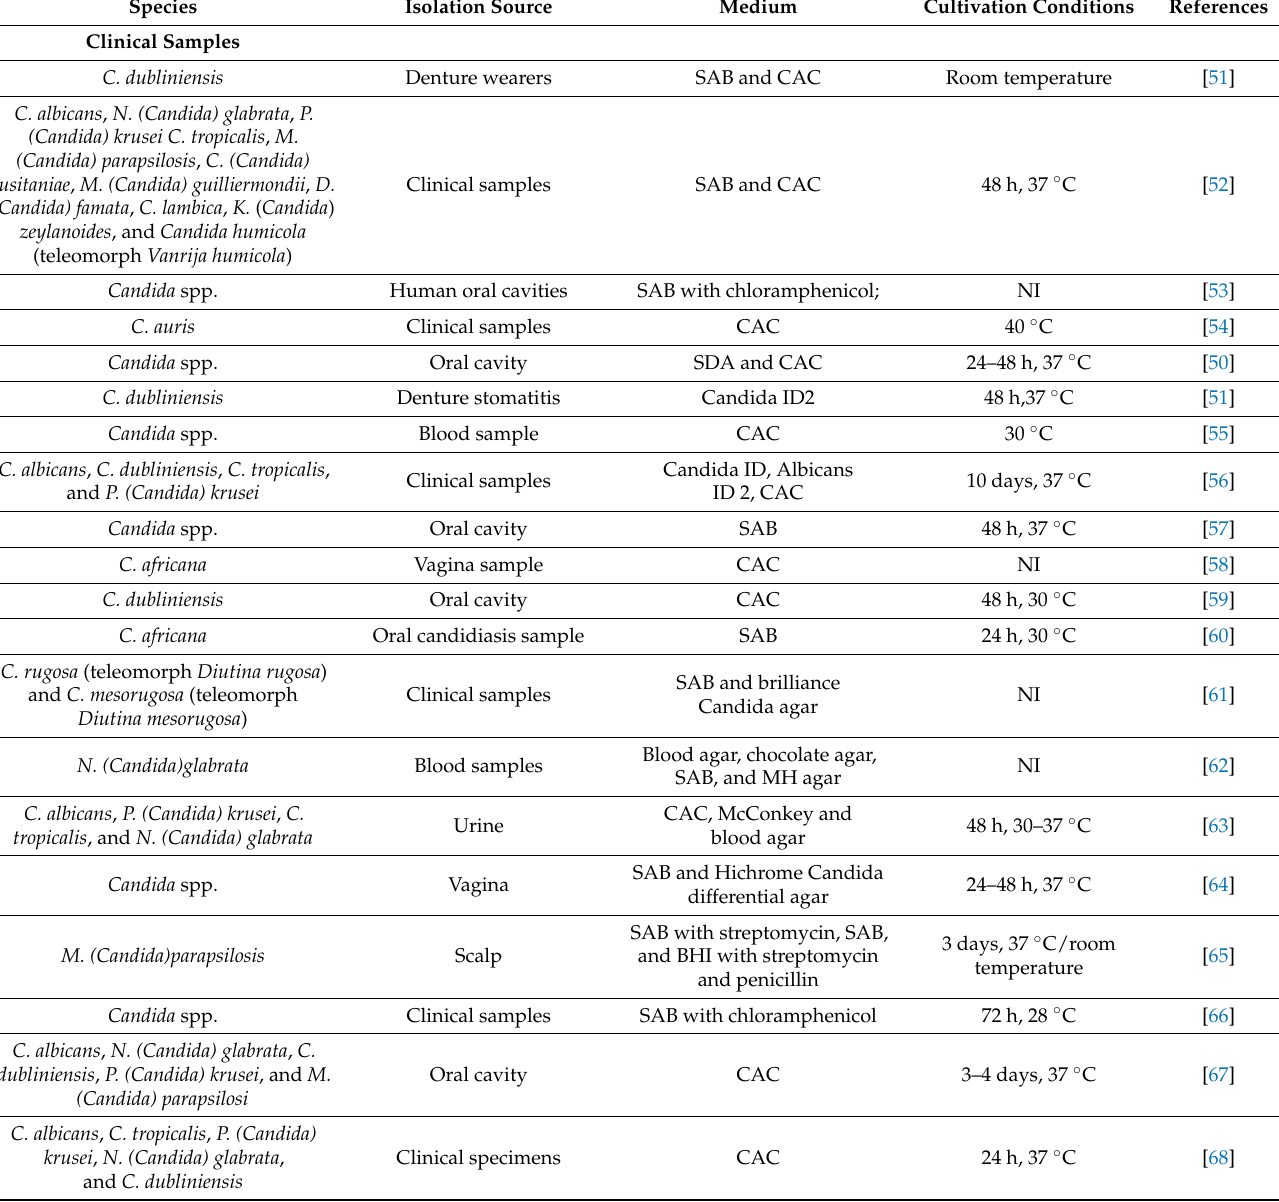
Table 1. Candida species isolation mediums and